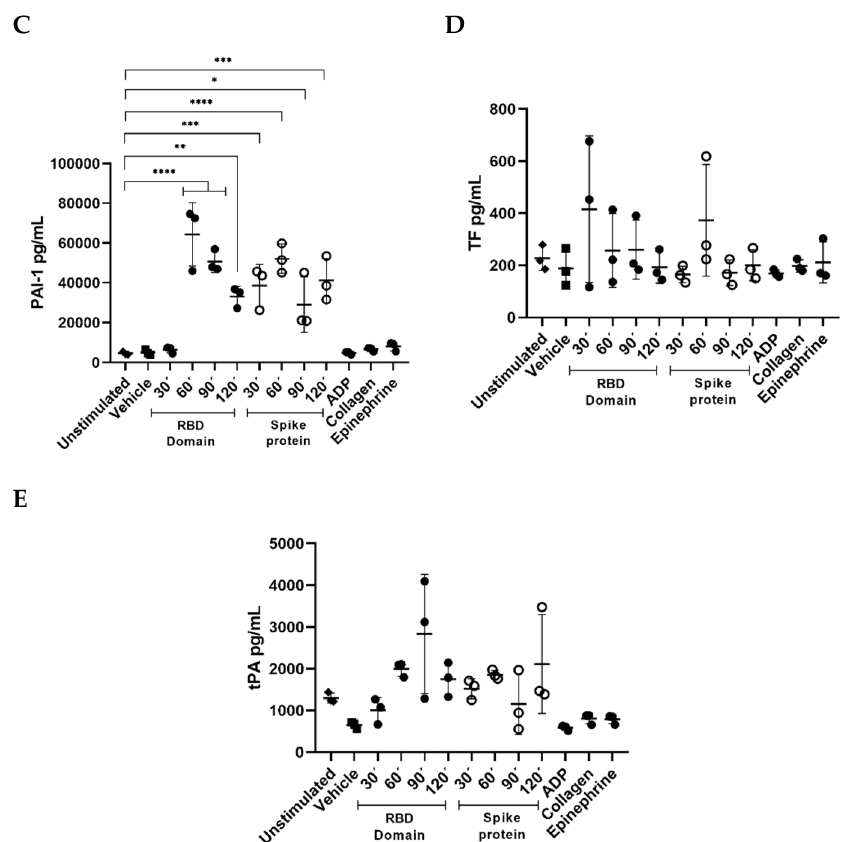
Figure 5. The spike protein and its RBD domain stimulate platelets´ release of pro-inflammatory factors. Comparison of supernatant concentration of ( A ) D-dimer, ( B ) FIX, ( C ) PAI-1, ( D ) TF and ( E ) tPA in PRP incubated with spike full-length protein (2.0 µ g/mL) and RBD domain (2.0 µ g/mL) at different times. Known platelet aggregation agonists were used as activation controls (20 µ M ADP, 20 µ M collagen, and 100 µ M epinephrine), Tyrode’s buffer was used as vehicle and PRP treated under the same conditions but without external stimuli as a negative control. p values were calculated using one-way ANOVA and Tukey’s post-hoc tests ( n = 3). Data presented as Mean ± SD. Statistical difference * p < 0.05, ** p < 0.01, *** p < 0.001, **** p < 0.0001.